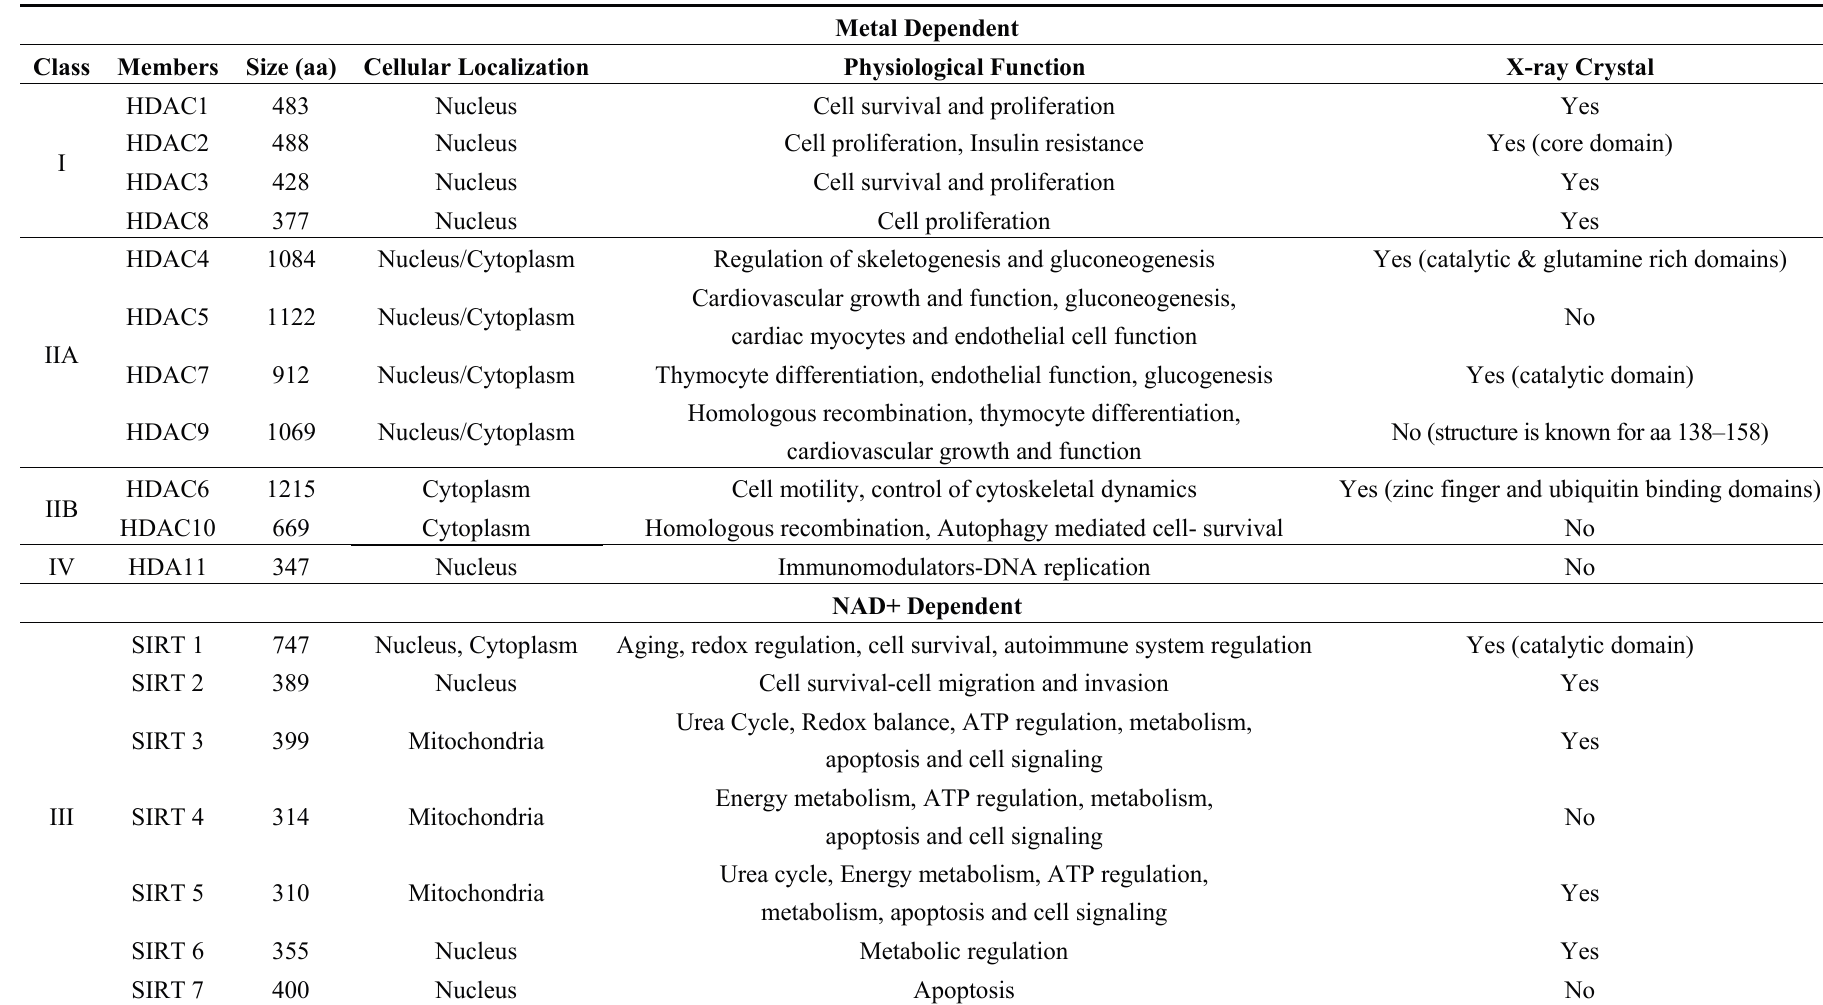
Table 1. Histone deacetylase enzymes: classification, amino acid size, cellular localization, physiological functions and crystal structure